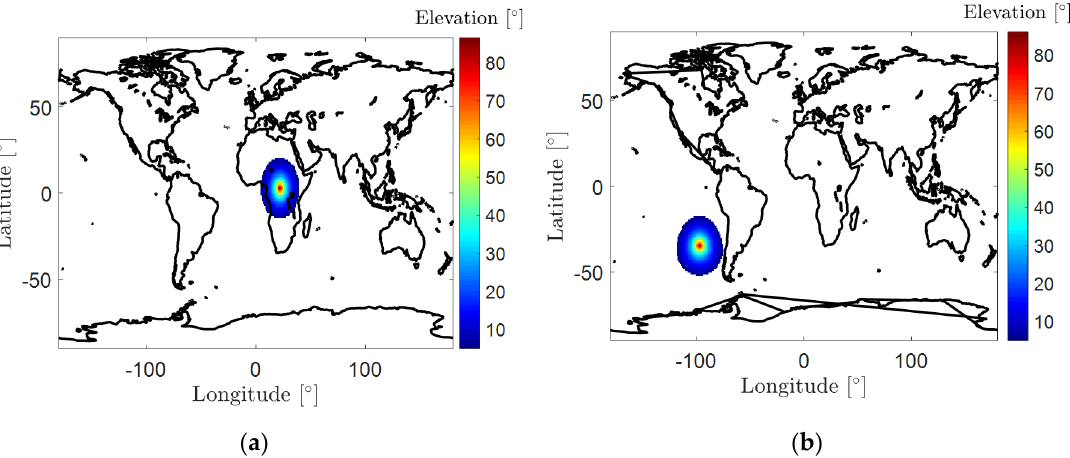
Figure 7. Areas observing GRACE FO-1 at ( a ) 4:15:00 and ( b ) 0:10:00 on 14 August 2018, with an elevation mask angle of 5°.